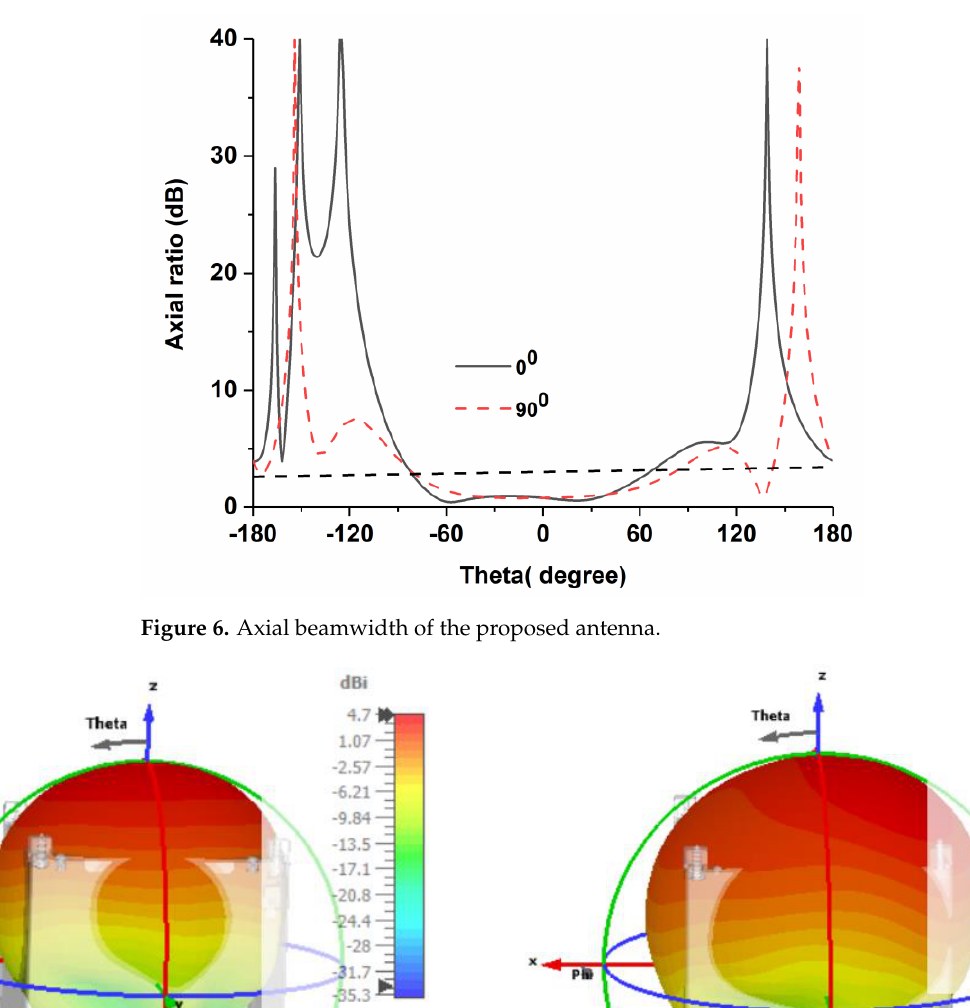
Figure 6. Axial beamwidth of the proposed antenna.